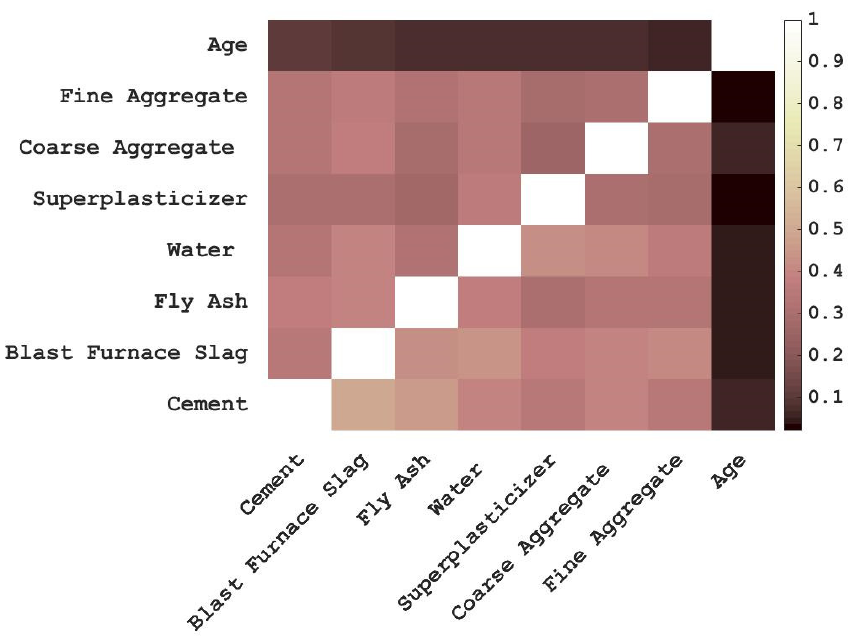
Figure 2. Correlation coefficients matrix diagram.